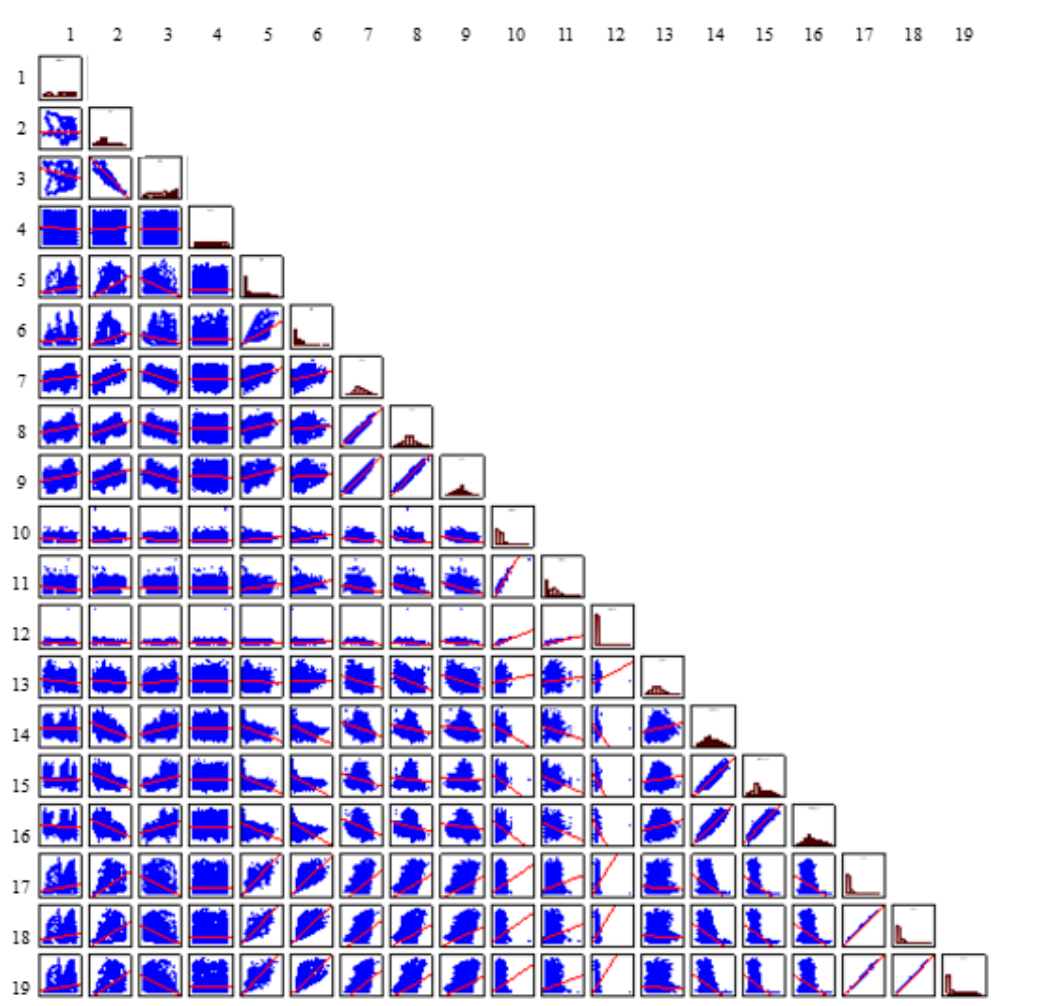
Figure 7. Correlation diagrams for all pairs of parameters (PQ and weather) when 1 min aggregation interval is used.